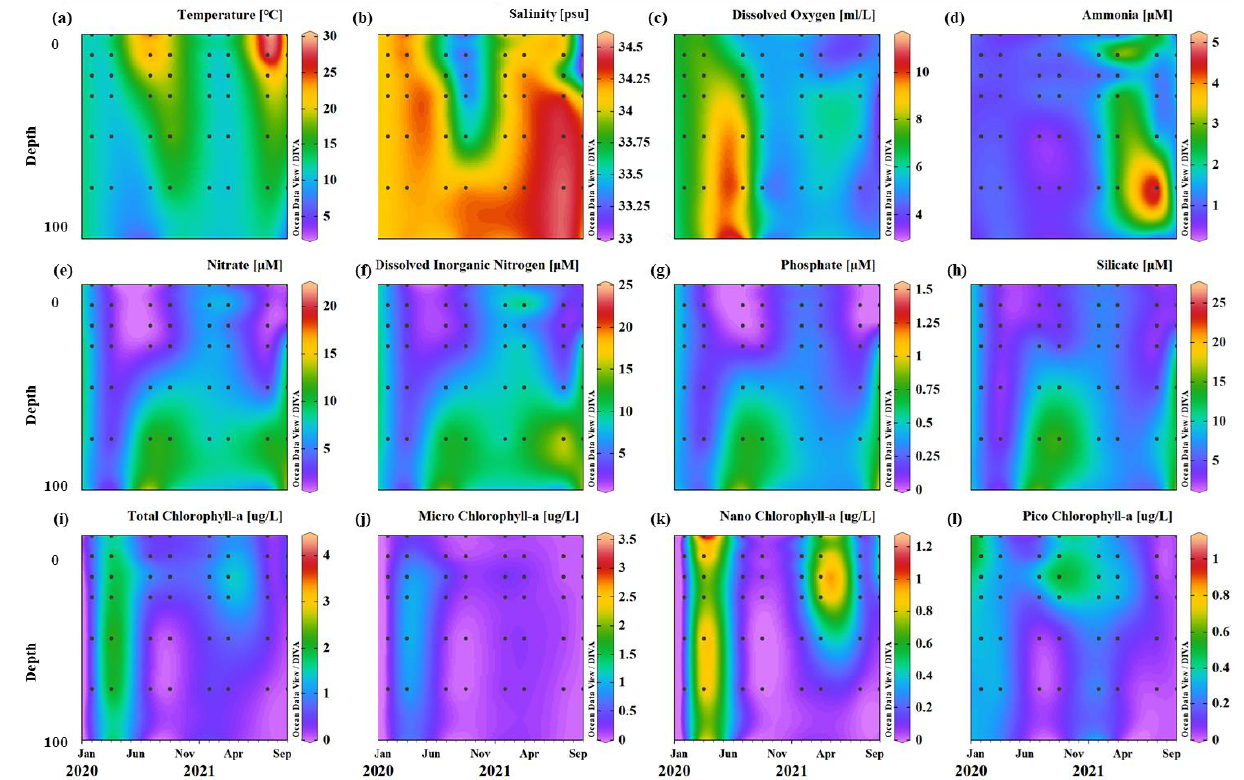
Figure 3. Monthly variation of temperature ( a ), salinity ( b ), dissolved oxygen ( c ), NH 4+ concentration ( d ), NO 3 2− concentration ( e ), dissolved inorganic N concentration ( f ), PO 43 − concentration ( g ), SiO 3 2− concentration ( h ), total chlorophyll- a concentration ( i ), micro chlorophyll- a concentration ( j ), nano chlorophyll- a concentration ( k ), and pico chlorophyll- a concentration ( l ) from 0 to 100 m at site 105-11. The white triangular mark indicates the month in which the zooplankton samples were collected.